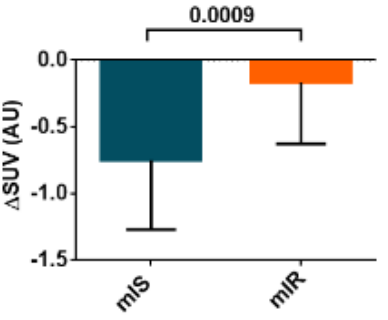
Figure 5 . Δ SUV in liver after performing an HEC procedure of both groups (mIR and mIS). Data are shown as median ± SD.